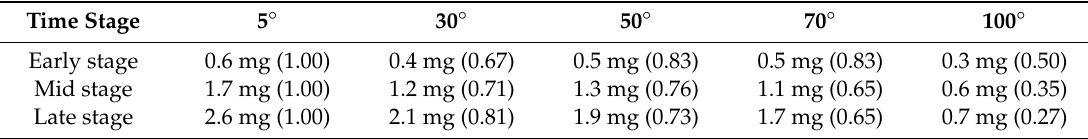
Table 1. Time integrals of fibrinogen infiltration and ratio of the time integral to the value when the contact angle between the implant surface and the blood plasma (CAIS) was 5°.